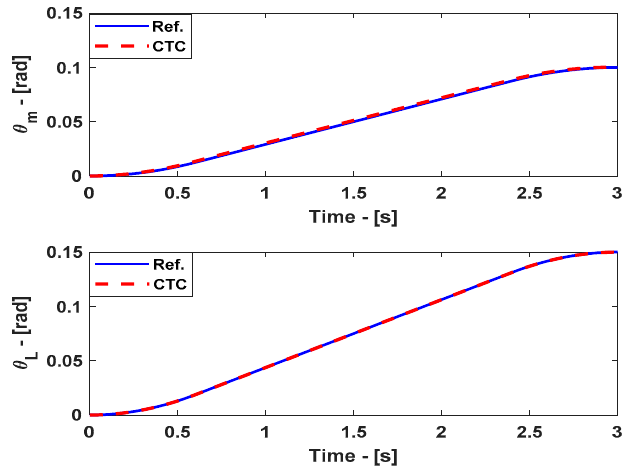
Figure 8. The responses of BcVSA by using the computed torque control (CTC) scheme under the condition when all the clutches are active ( K eq = 7 K 0 ) for the entire simulation time. ( Top ) the input trajectory response; ( Bottom ) the output response.